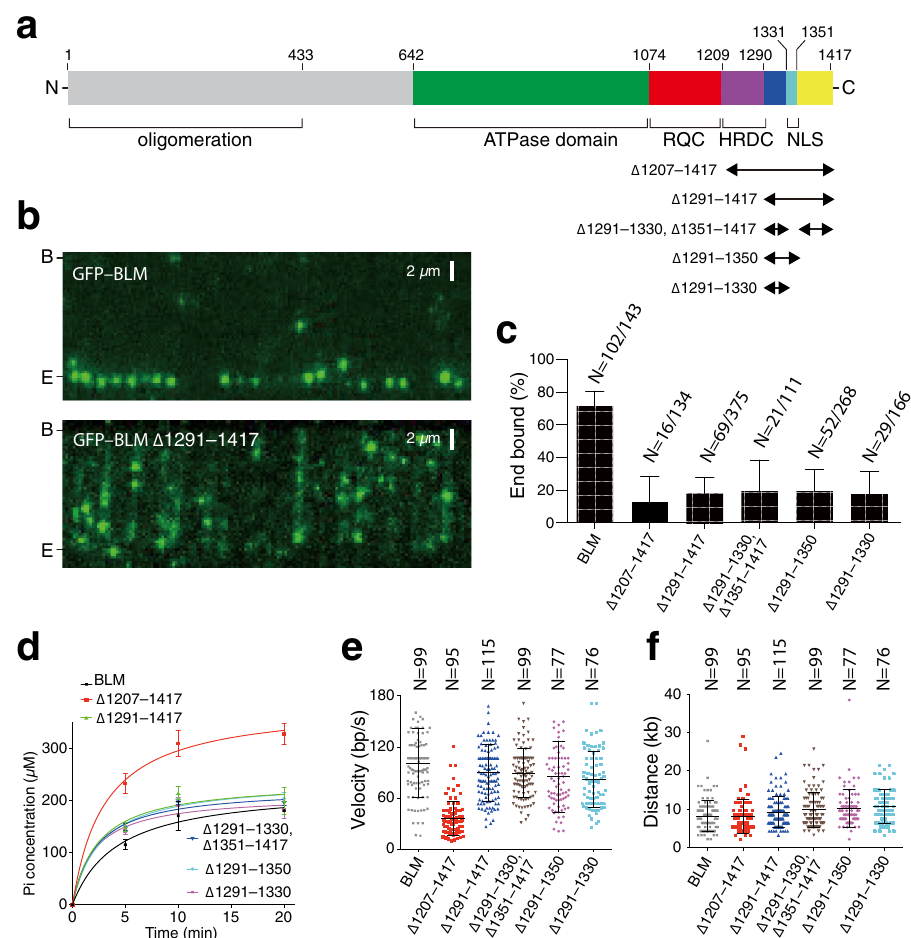
Fig. 5 The CTD of BLM contributes to DNA end-binding activity. a Schematic showing the domain organization of BLM. Black arrowheads indicate the CTD truncation mutants analyzed in this study. b Wide- fi eld TIRFM images showing full-length GFP-BLM (green) vs. GFP-BLM Δ 1291 – 1417 bound to a single- tethered dsDNA curtain (unlabeled). Note, the upper panel (BLM) is reproduced from Fig. 1b for comparison. c Fraction of end-bound BLM complexes for each of the CTD deletion constructs compared to full-length BLM. The height of each bar represents the percentage end-bound BLM molecules and error bars represent 95% con fi dence intervals (CI) calculated from bootstrap analysis. Also see Supplementary Fig. 6. d ATP hydrolysis assays with the BLM CTD truncation mutants. All reactions contained 5 nM of the indicated BLM construct and M13 ssDNA (2 μ M nucleotides). Data points represent the mean and error bars represent SD from three independent experiments. e Translocation velocity of BLM CTD truncation mutants bound to internal positions on the DNA. The center bar represents the mean of the data and error bars represent SD. Also see Supplementary Table 1. f Processivity of BLM CTD truncation mutants bound to internal positions on the DNA. The center bar represents the mean of the data and error bars represent SD. Also see Supplementary Table